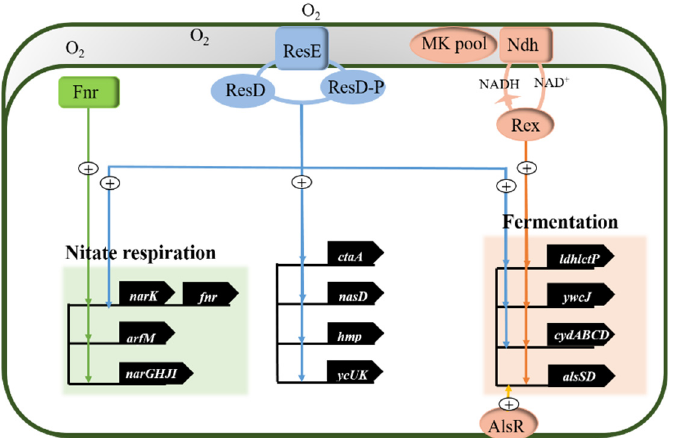
Figure 1. Anaerobic regulation network of Bacillus subtilis . Adapted from [81]. The green line represents that the Fnr regulator positively induces the nitrate respiration genes expression including narK gene, fnr gene, arfM gene, and narGHJI operon; The blue line represents that the ResD-ResE system positively regulate the expression of ldhlctP operon (encoding L-lactate dehydrogenase and lactate permease), nasDEF gene (encoding the assimilatory nitrite reductase), hmp gene (coding for a flavohemoglobin), ctaA gene (encoding a heme A sythase), narK gene (encoding the nitrate reductase), fnr gene (encoding the Fnr regulator), ywcJ gene (encoding a heme A sythase), and cydABCD gene (encoding a heme A sythase); The orange line represents that the Rex regulator positively stimulates the fermentation genes expression, including ldhlctP operon, ywcJ gene, cydABCD gene, and alsSD gene. The AlsR regulator positively induces the alsSD gene expression.